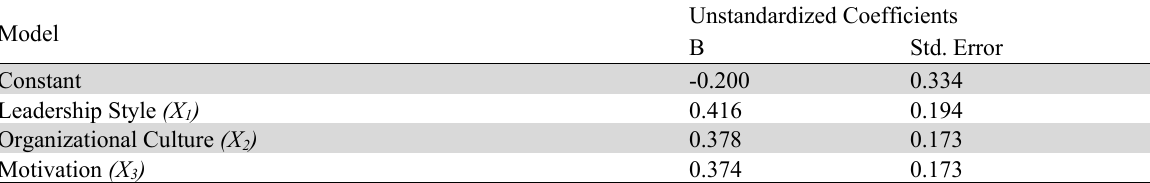
The summary of the results of regression analysis